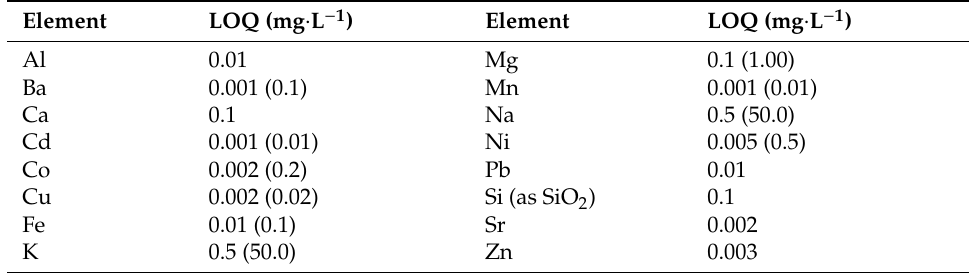
Table 1. Limits of Quantification (LOQ) of the measurement elements by ICP-OES. Element